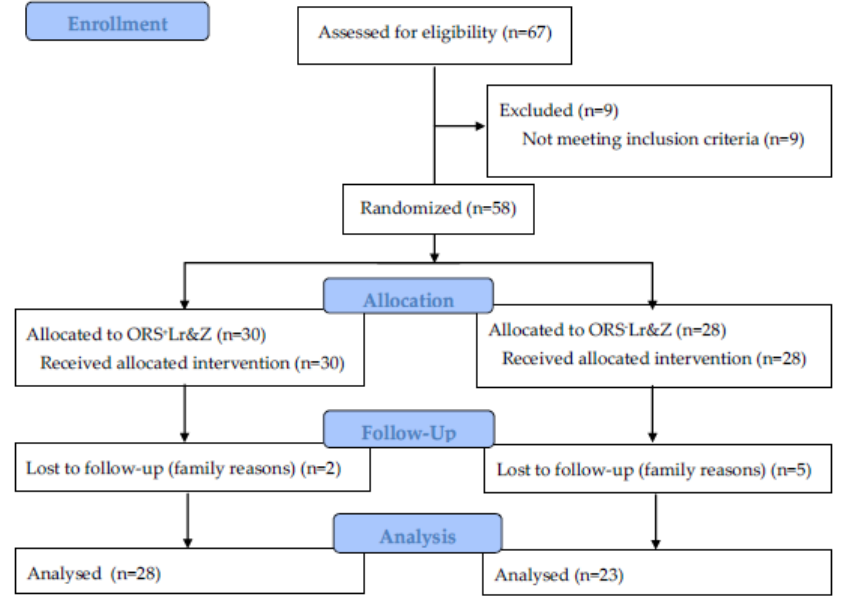
Figure 1. CONSORT flow diagram.